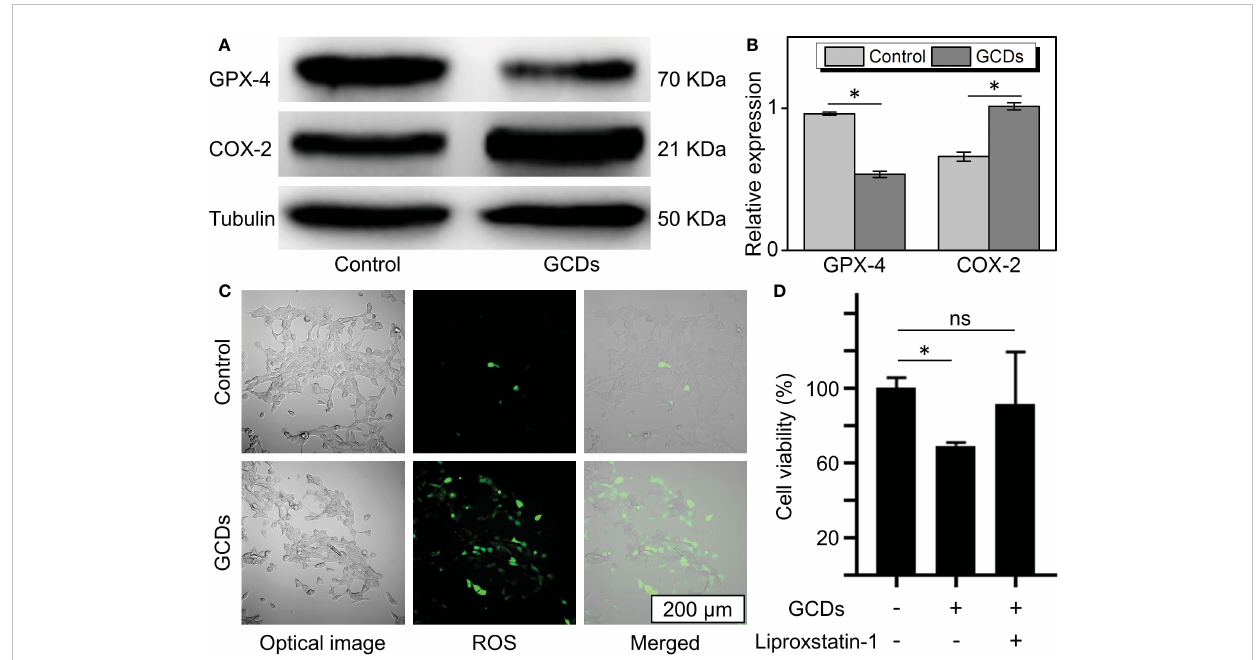
FIGURE 4 Ginseng-based carbon dots (GCDs)-induced ferroptosis of cancer cells. (A, B) Western blot of ferroptosis-related protein (GPX-4 and COX-2) expression of Cal-27 treated with GCDs (300 m g/mL) for 24 h. (C) Images of reactive oxygen species (ROS) expression assay with green fl uorescence. (D) Cell counting kit-8 (CCK-8) assay for the viability of cancer cells treated with GCDs or the inhibitor of ferroptosis (liproxstatin-1). Data are presented as mean ± SD from three experiments. * P<0.05; ns stands for Not Statistically.